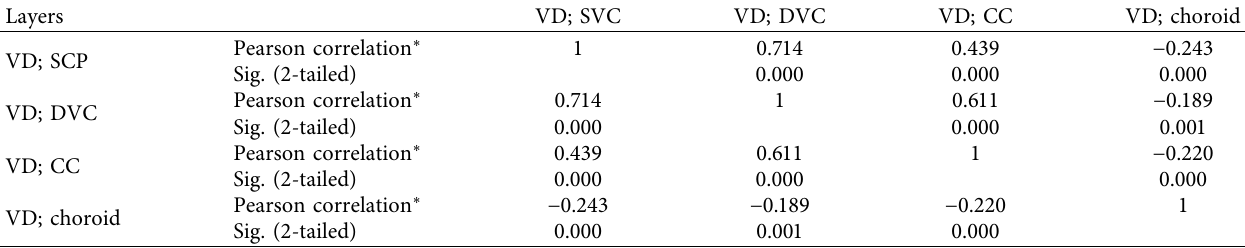
Table 3: Correlation between vessel densities of different retinal and choroidal layers.